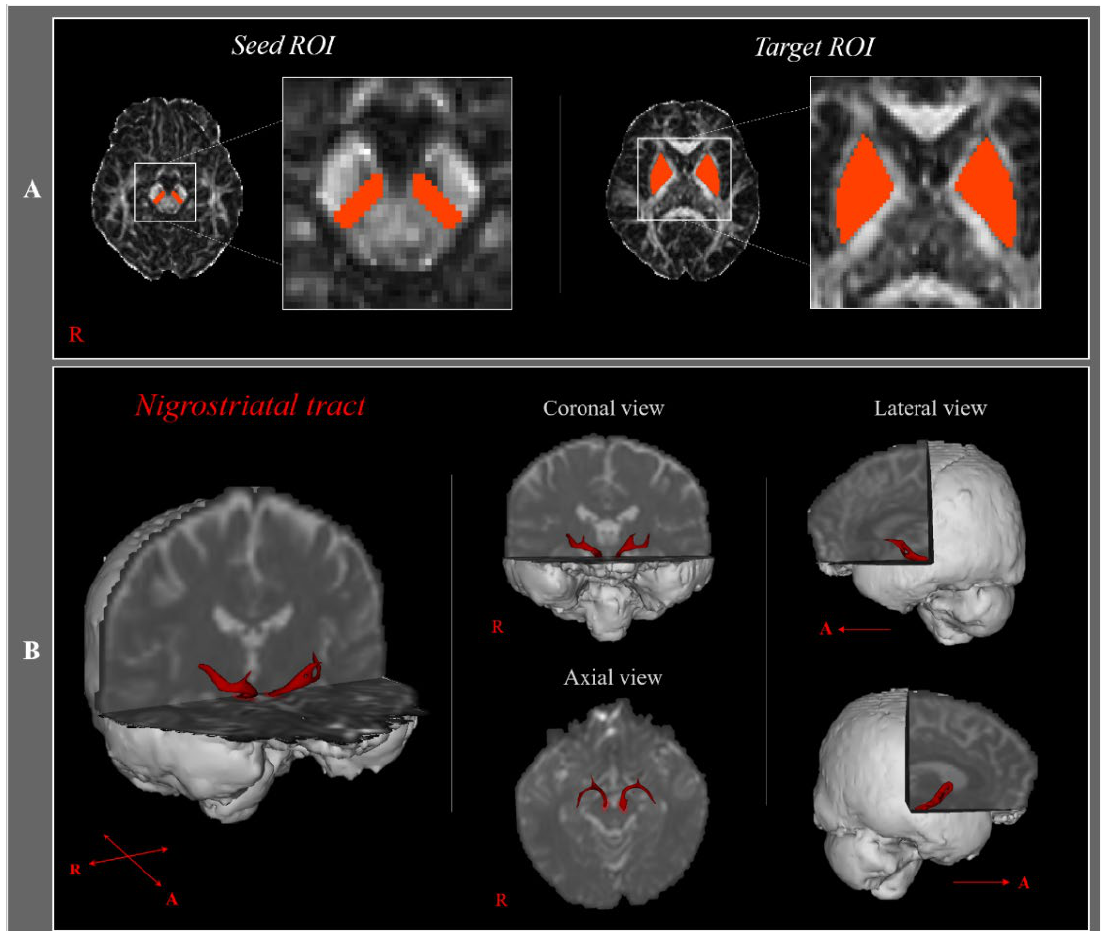
Figure 1. ( A )—The region of interest (ROI) and diffusion tensor tractography for the nigrostriatal tract. The first ROI was placed on the substantia nigra, and the second ROI was placed on the striatum. ( B )—In both hemispheres, the NST is being reconstructed. T2-weighted brain magnetic resonance images showing a representative subject (20-year-old female); R: right; A: anterior